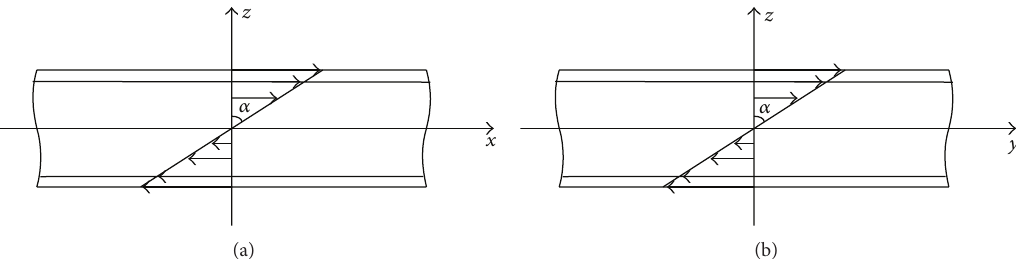
Figure 7: Two-dimensional strain distribution of a plate with two antisymmetric colocated piezoelectric elements: (a) 𝑧 - 𝑥 plane and (b) 𝑧 - 𝑦